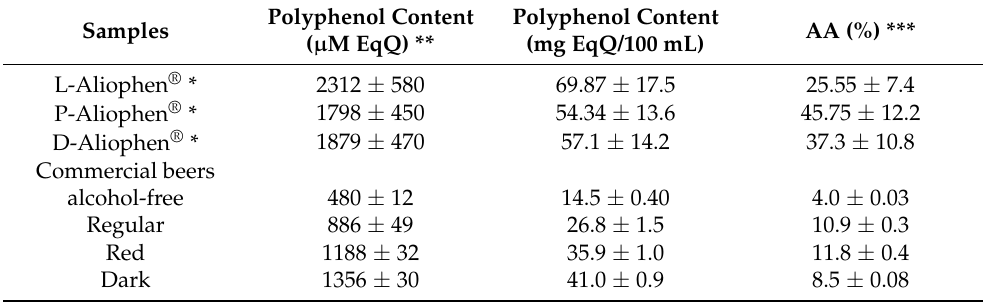
Table 1. Polyphenolic content, of different Aliophen ® formulations compared to commercial beers. Samples